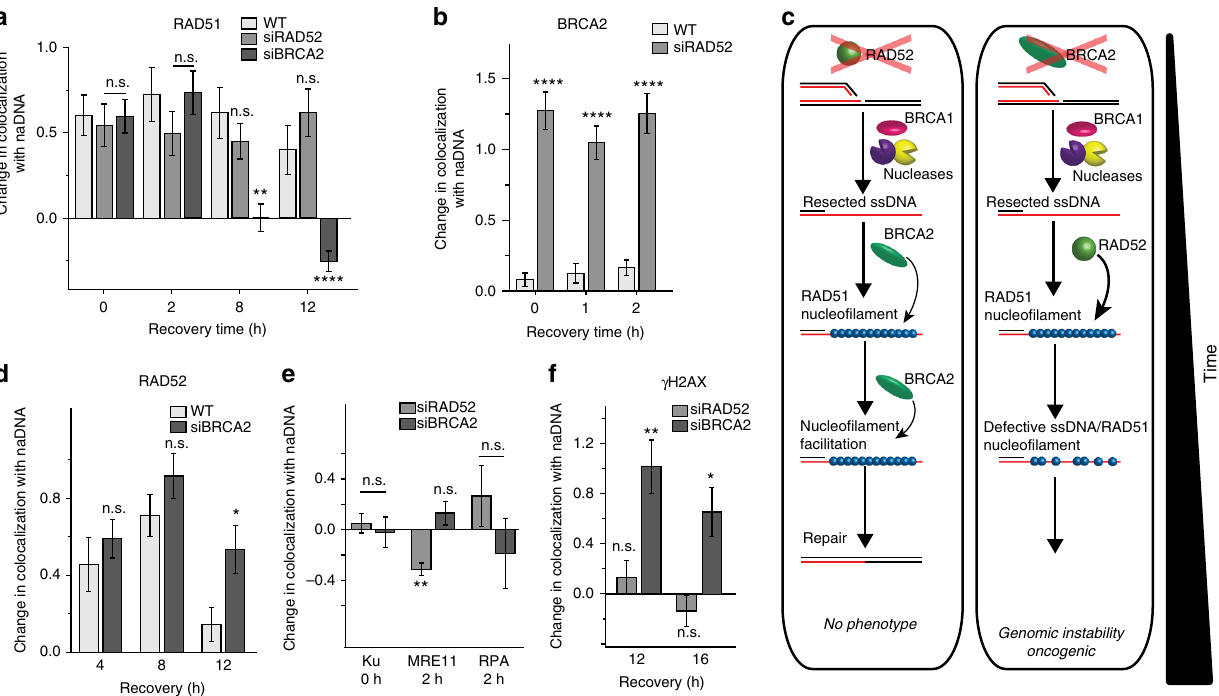
Fig. 5 Early critical ssDNA/RAD51 interactions can be facilitated by either RAD52 or BRCA2. a Quanti fi cation of RAD51 association with repair foci during early (0, 2 h) and late (8, 12 h) HR in RAD52- and BRCA2-depleted cells. b Quanti fi cation of BRCA2 association with repair foci during early (0, 1, 2 h) HR in RAD52-depleted cells. c Representations of the HR repair pathway and its de fi ciencies in RAD52 and BRCA2 depleted cells. d Quanti fi cation of RAD52 association with repair foci during the homology search stage of HR (4, 8, 12 h) in BRCA2-depleted cells. e Quanti fi cation of Ku, MRE11, and RPA association with repair foci during early HR (0 or 2 h) in siRAD52- and BRCA2-depleted cells. f Quanti fi cation of γ H2AX association with repair foci during late HR (12, 16 h) in RAD52- and BRCA2-depleted cells. For complete N values, see Supplementary Table 1. Error bars represent mean ± s.e.m. Student ’ s t test for signi fi cance between WT + CPT and siRNA + CPT as indicated. n.s. p > 0.05, * p < 0.05, ** p < 0.01, **** p < signaling as detected by γ H2A.X association (Supplementary